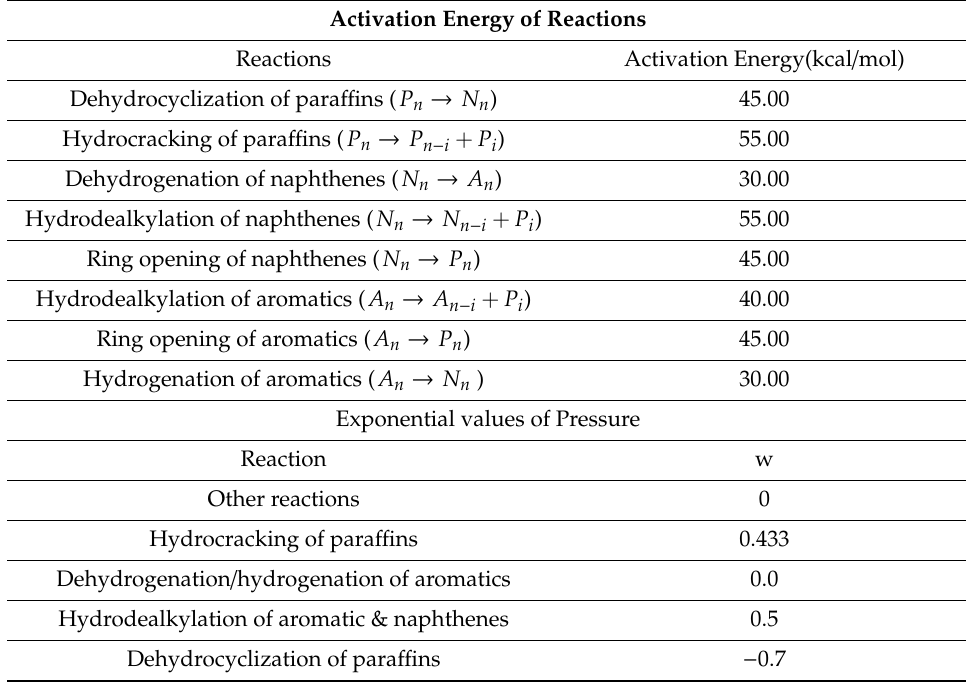
Table 3. Activation Energies for the reactions and Exponential values of Pressure (adapted from